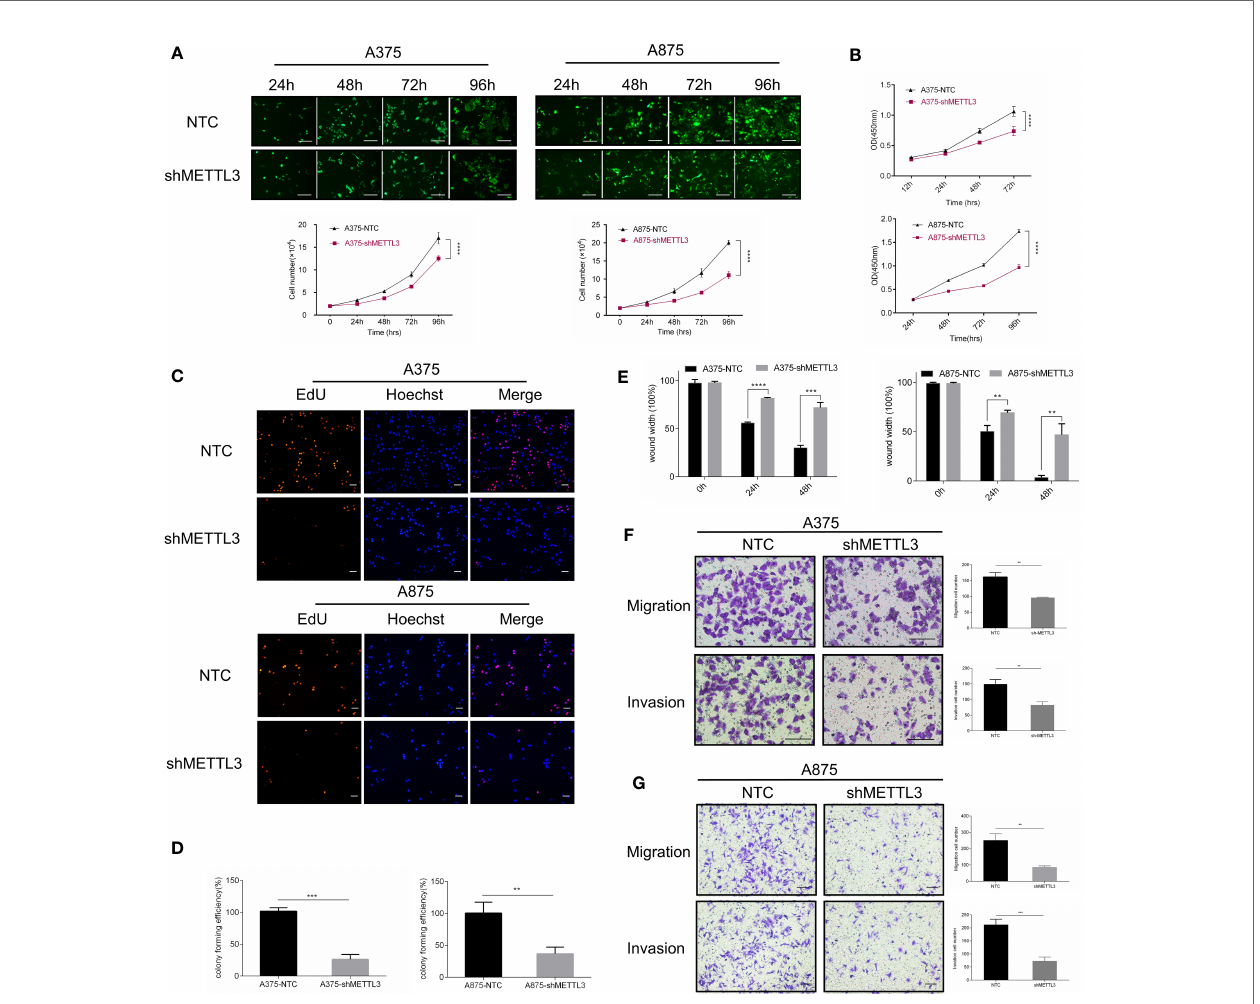
FIGURE 3 | METTL3 knockdown inhibits melanoma cell proliferation, migration, and invasion in vitro . (A) Continuous cell count of A375 and A875 transfected cells with GFP re fl ected cell proliferation ability. (B) Cell proliferation assay by CCK8 method. (C) EdU cell proliferation, EdU (red), Hoechst (blue), scale bar = 100 m m. (D) Quanti fi cation of the results from colony-formation assay. (E) The statistical histogram of wound-healing assays in A375 and A875 transfected cells. Transwell assays with or without Matrigel indicated suppressed migration and invasion of (F) A375 and (G) A875 cells following METTL3 knockdown. Bar = 100 m m. Mean ± SD of each group (n = 3). Signi fi cant differences were evaluated using two-way or one-way ANOVA. **P < 0.01, ***P < 0.001, ****P <